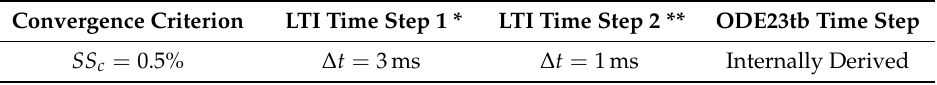
Table 5. Amended convergence criterion and time step study